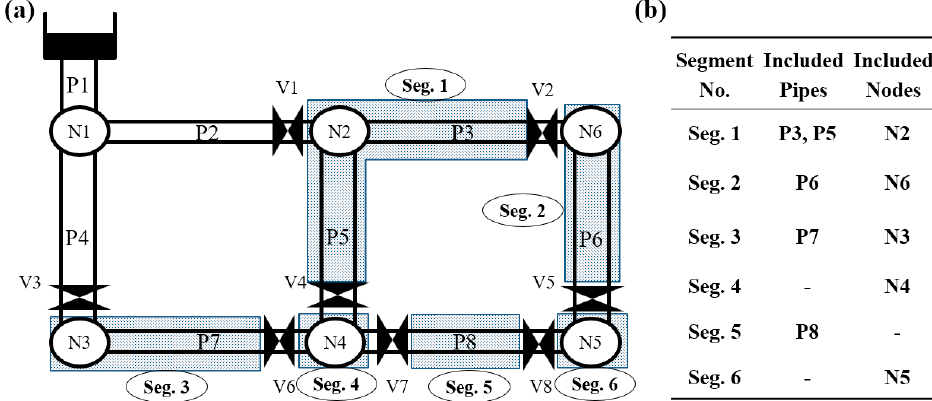
Figure 4. Example of segment identification: ( a ) Example network; ( b ) Results of segment identification.